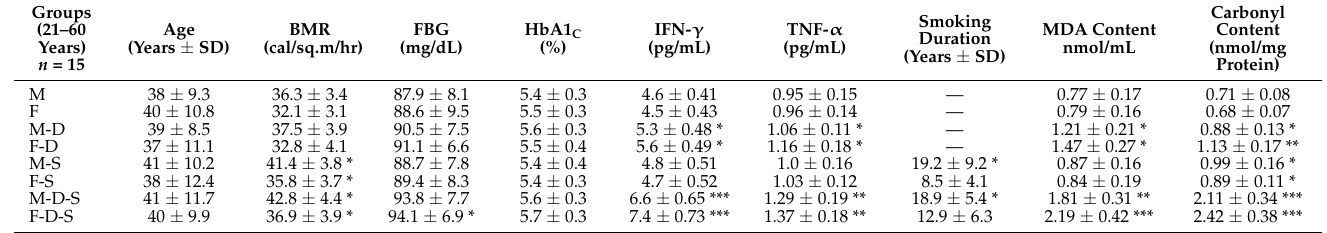
Table 1. Clinical characterizations of individuals based on gender and smoking habits.